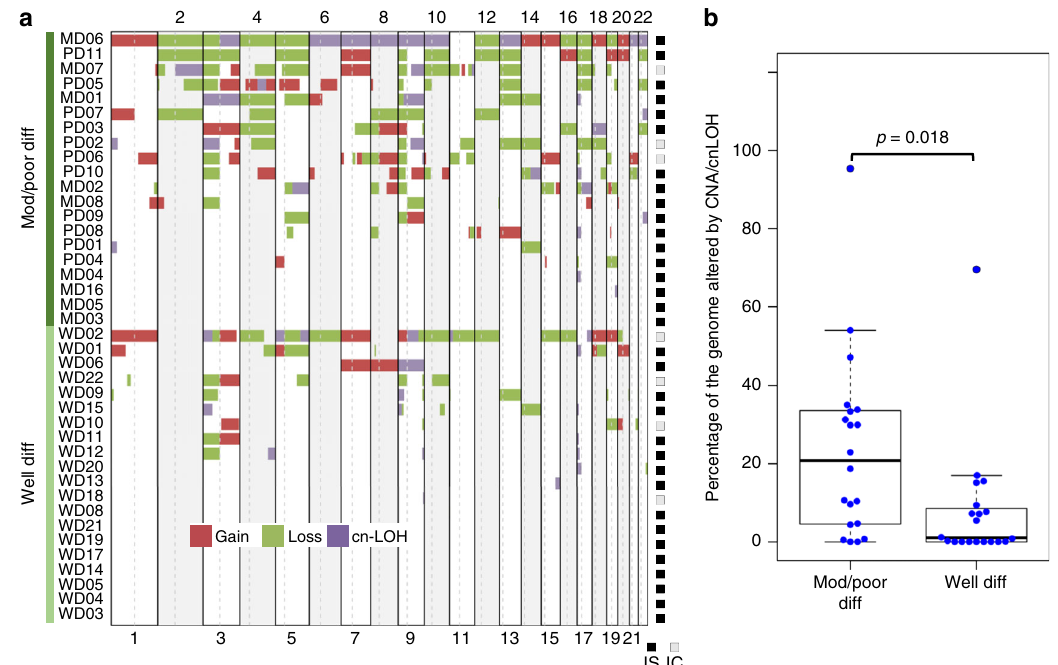
Fig. 2 Somatic copy number aberrations (SCNA) and LOH events in 40 cSCC samples. a OncoPrint of copy gain, loss and copy-neutral (CN)-LOH segments across moderate/poor and well-differentiated groups. IS immunosuppressed, IC immunocompetent. b Box-and whisker plot indicating the percentage of the genome altered by CNA/LOH across the two groups. Individual values were shown by the blue dots. Moderate/poor differentiated group had signi fi cantly higher percentage of altered genome than well-differentiated group (Student ’ s t -test, two sided, p =